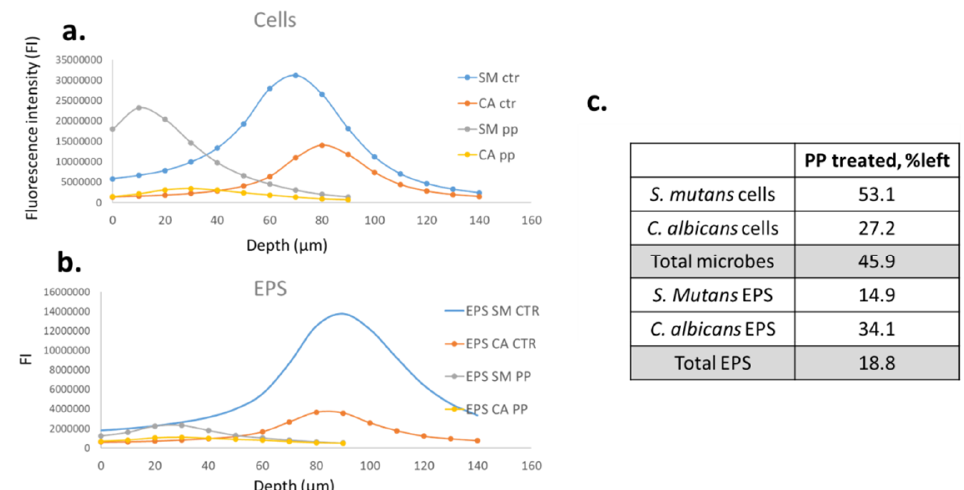
Figure 3. Quantification of the confocal laser scanning microscopy results. Charts a + b show the fluorescence intensity in each layer of the biofilm depth. ( a ) Cells quantification of the control and the treated groups. ( b ) EPS quantification of the control and the treated groups. ( c ) A table summing up the percentage of cells and EPS left after the various treatments relative to the control.